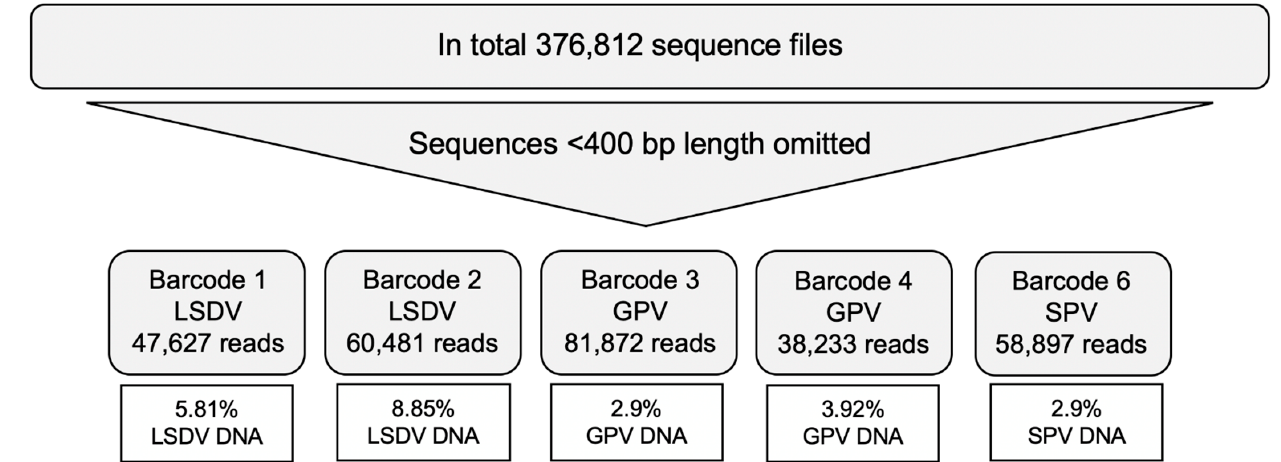
Figure 1. Filtration, classification and viral DNA amount of barcoded sequence files. Offline BLAST specificities of 5, 10 and 15 kbp genome regions, whole genome, RPO30, P32 and GPCR genes databases were calculated by dividing the number of hits that correctly aligned by the total number of hits (results are summarized in Figure 2).